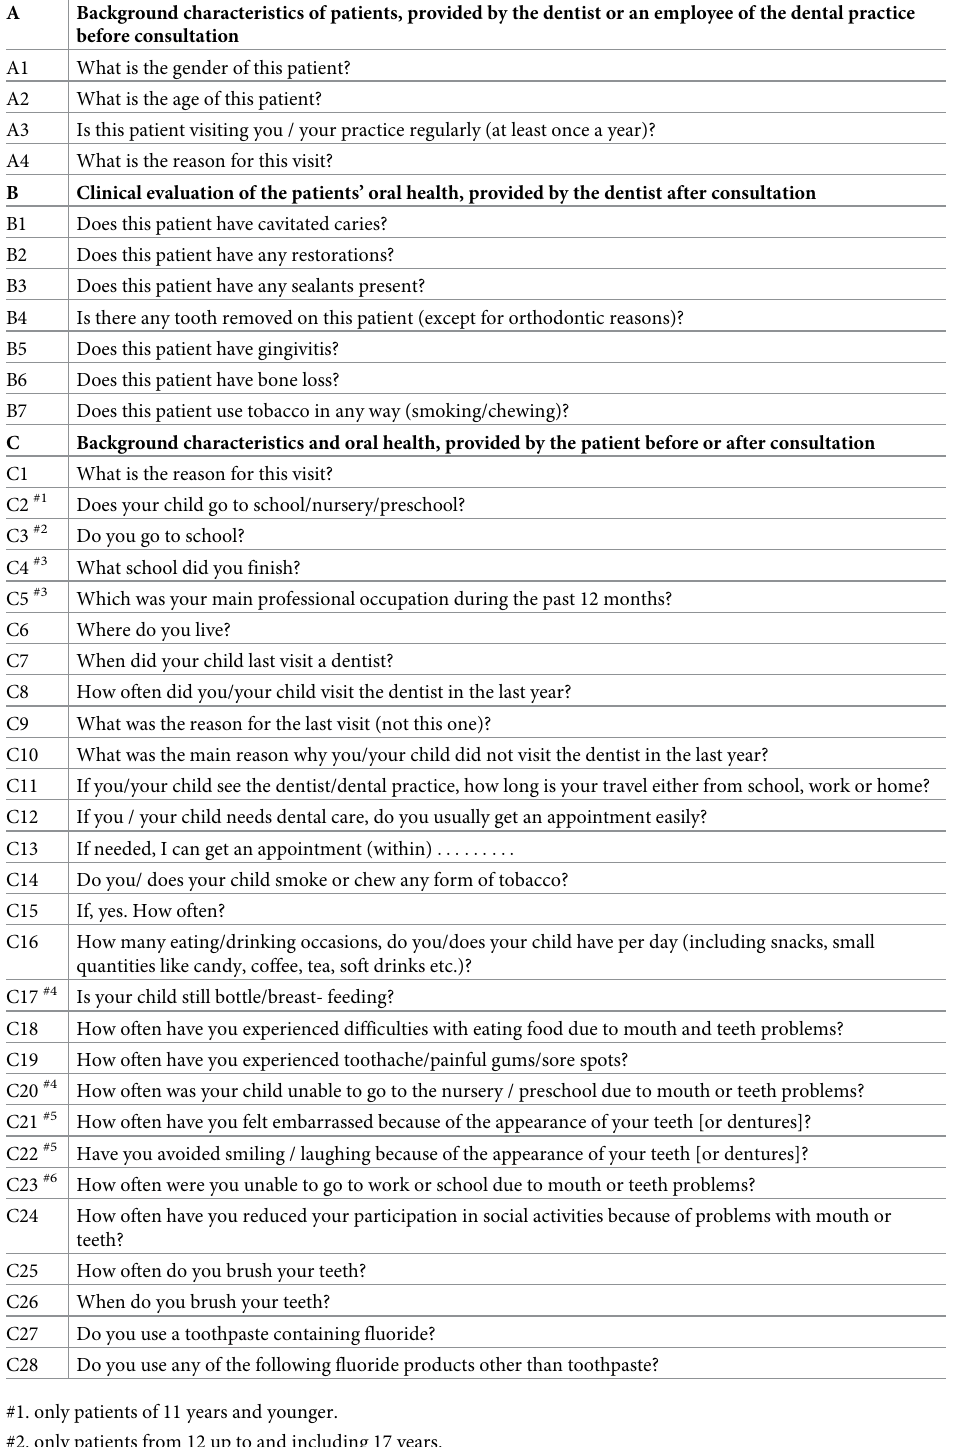
Table 1. Questions of the questionnaires of the proof of concept study of the oral health